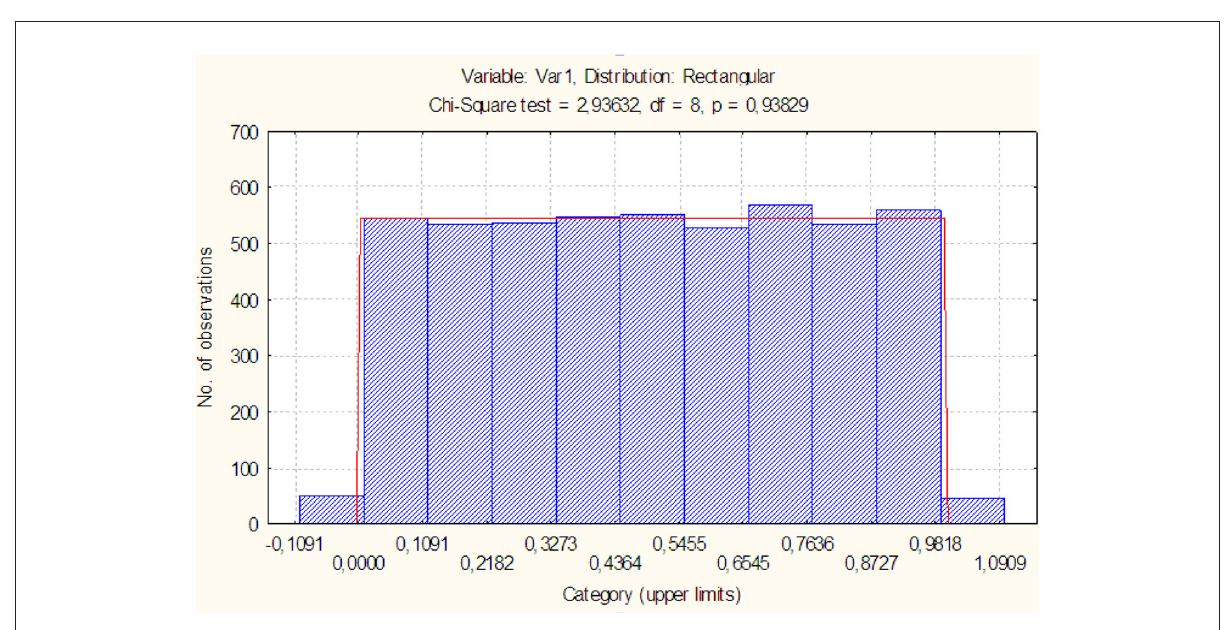
FIGURE6 Histograms of distributions of statistics υ 1 ≤ υ 2 .